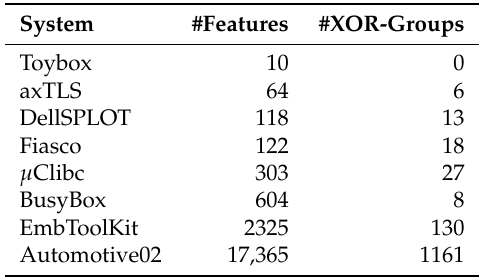
Table 1. Number of features and XOR-groups for each